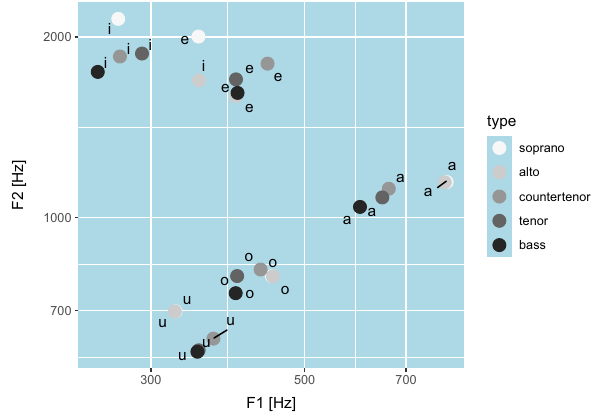
Figure 1. Disposition of the five cardinal vowels /a, e, i, o, u/ on the plane of the lowest two formant frequencies F1 and F2, for five different voice types. The vowel coordinates are commonly used as preset parameters in singing-voice synthesizers 26,45